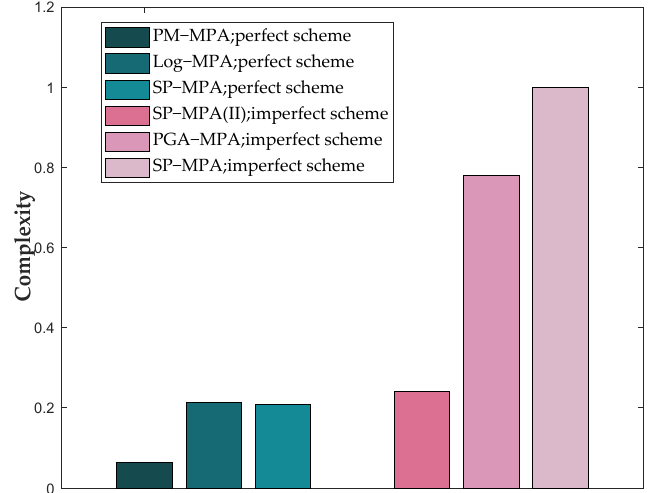
Figure 19. Convergence of the codeword probability.